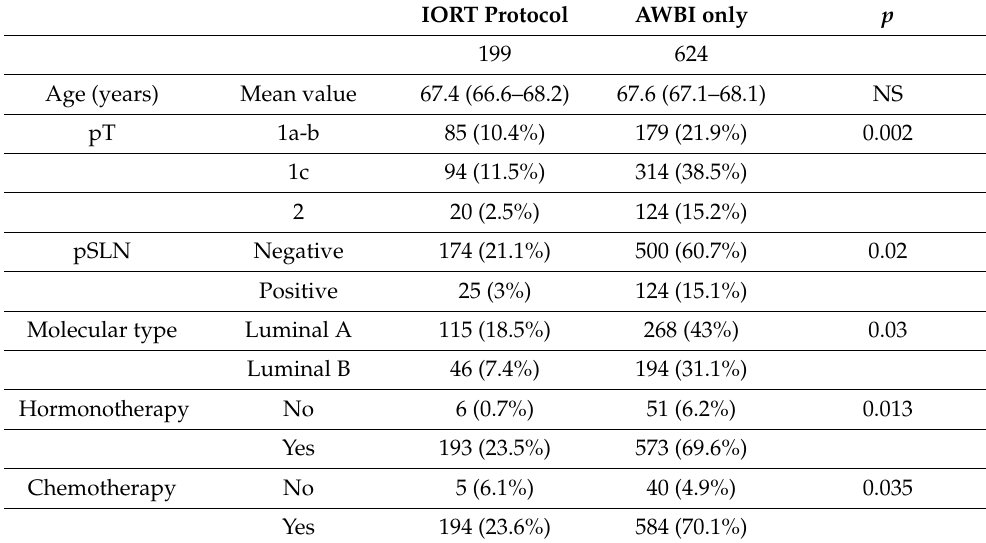
Table 2. Characteristics of patients analyzed in study.